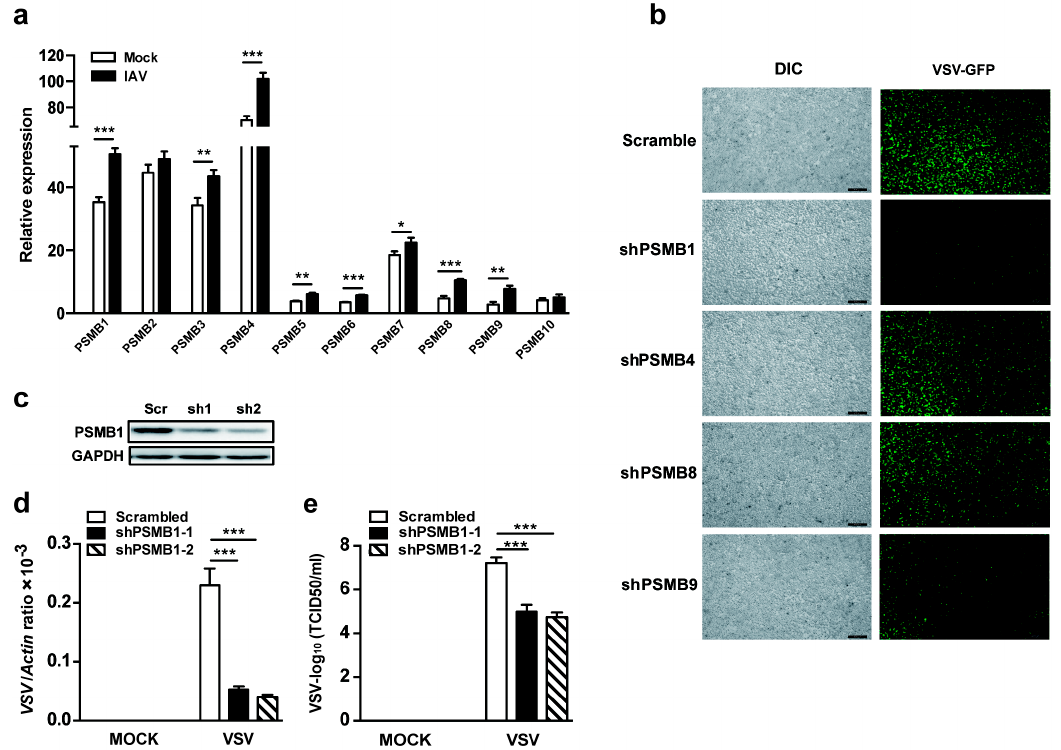
Figure 1. PSMB1 (proteasome β subunit 1) is involved in cellular antiviral responses. ( a ) Quantification of PSMB mRNA levels by qPCR in THP-1 cells after influenza A virus (IAV, PR8 strain) infection for 24 h, multiplicity of infection (MOI) = 1. ( b ) Microscopic images of vesicular stomatitis virus (VSV)-GFP-infected HEK293T cells expressing either scrambled shRNA or indicated PSMB -specific shRNA. Images were acquired with a Leica fluorescence microscope. Scale bars, 100 µ m. ( c ) Immunoblot analysis of PSMB1 expression in HEK293T cells stably expressing shRNA against PSMB1 . (d, e) Quantification of VSV loads by qPCR ( d ) and VSV titers by TCID50 ( e ) from HEK293T cells stably expressing either scrambled shRNA or PSMB1 -targeting shRNA after VSV infection for 12 h (MOI = 0.1). Data shown are the mean ± SEM; * p < 0.05, ** p < 0.01, *** p < 0.001. Representative